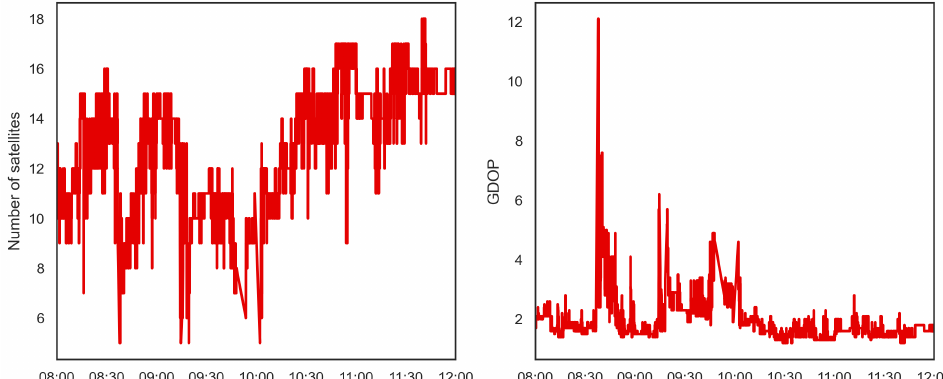
Figure 4. The number of visible satellites ( left ) and GDOP values ( right ) along the CS1